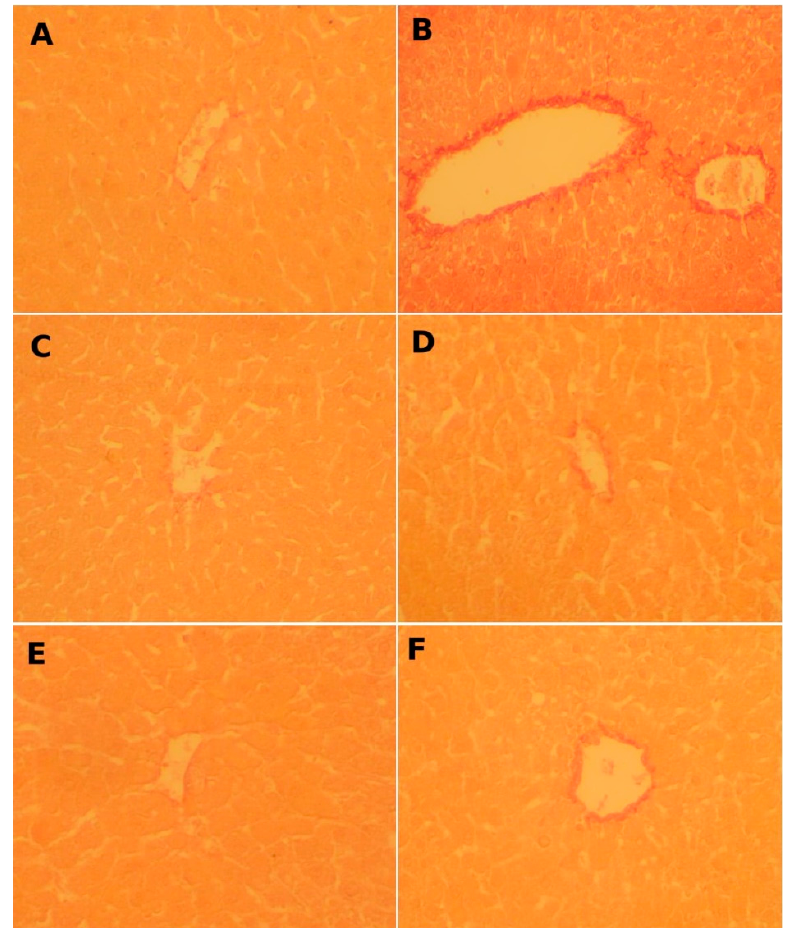
Figure 3. Micrograph showing the effect of FLE and DLE on hepatic fibrosis caused by CCl 4 . Assessment by Sirius red stain (G x 200). ( A ) Control, ( B ) CCl 4 -treated, showing intensified red stain. ( C ) FLE-treated (30 mg/kg), and ( D ) co-treated with CCl 4 and FLE (30 mg/kg). ( E ) DLE-treated (30 mg/kg) showing normal collagen deposition and ( F ) co-treated with CCl 4 and DLE (30 mg/kg).